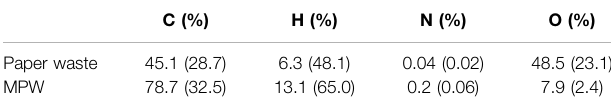
TABLE 1 | Ash-free elemental analysis of the major constituents of paper and plastic waste. Results are given in wt% with mol% in parenthesis. C